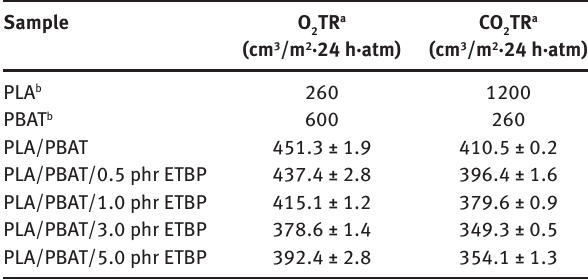
Table 5: Gas permeability of different